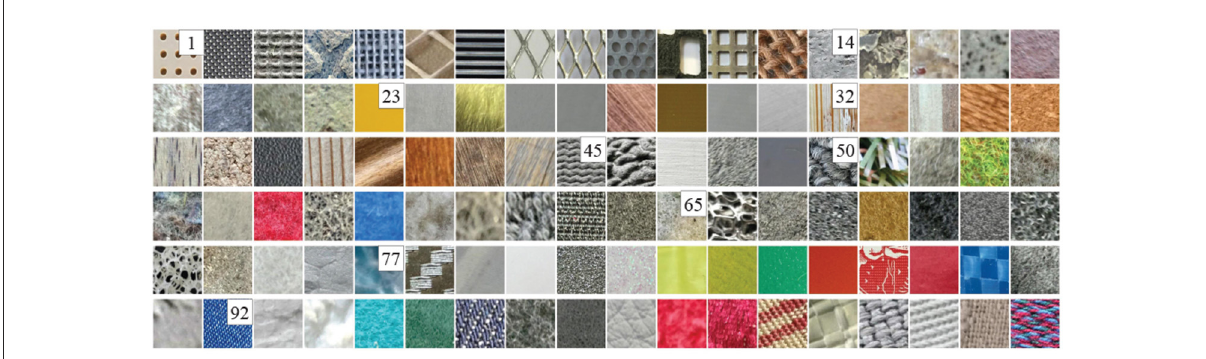
FIGURE3 All material images of the data set. The numbers, respectively, denote the beginning of each category. The original images are from Strese et al. (2016). It has been reproduced with permission from IEEE, available at https://zeus.lmt.ei.tum.de/downloads/texture/.